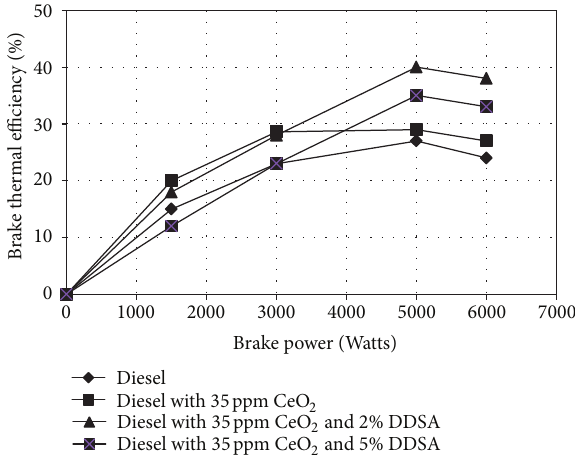
Figure 9: Variation of the brake thermal efficiency with load, for diesel and modified diesel (35 ppm of CeO 2 ) with different vol % of